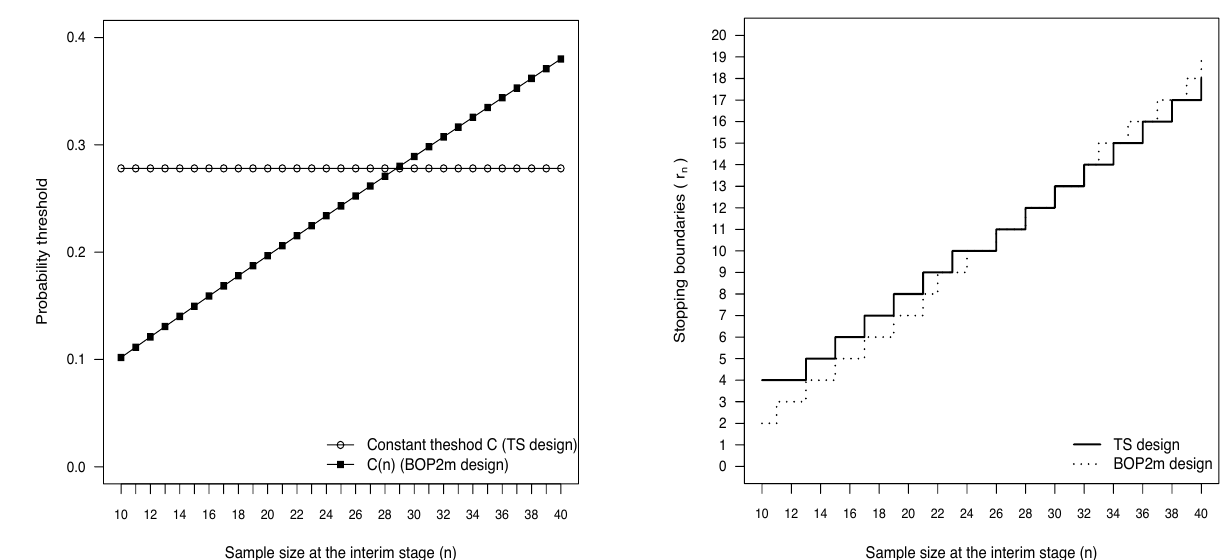
Figure 1. Behavior of the calibrated thresholds C and C ( n ) as a function of n ( left panel ) and stopping boundaries of the TS and BOP2m designs ( right panel ), when λ = 0.38, γ = 0.95, N = 40, N min = 10, δ = 0.1, π ( p S ) = beta ( p S ;63,94 ) , π ( p E ) = beta ( p E ;1.4,1.6 ) and the nominal level for the type I error rate is